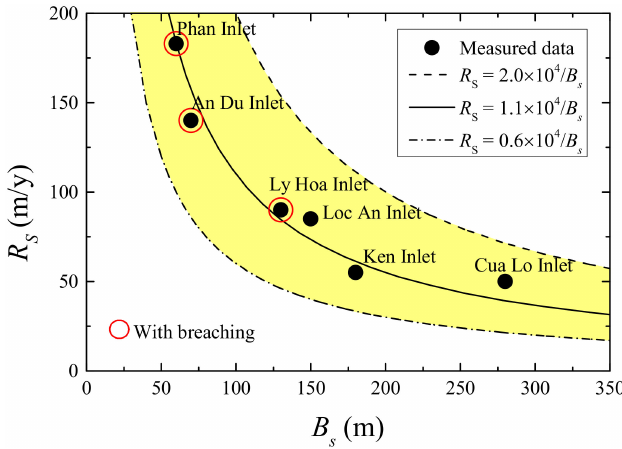
Figure 15. Relationship between the sand spit growth rate and sand spit